Question: Compose a caption that would accompany this figure in a paper.
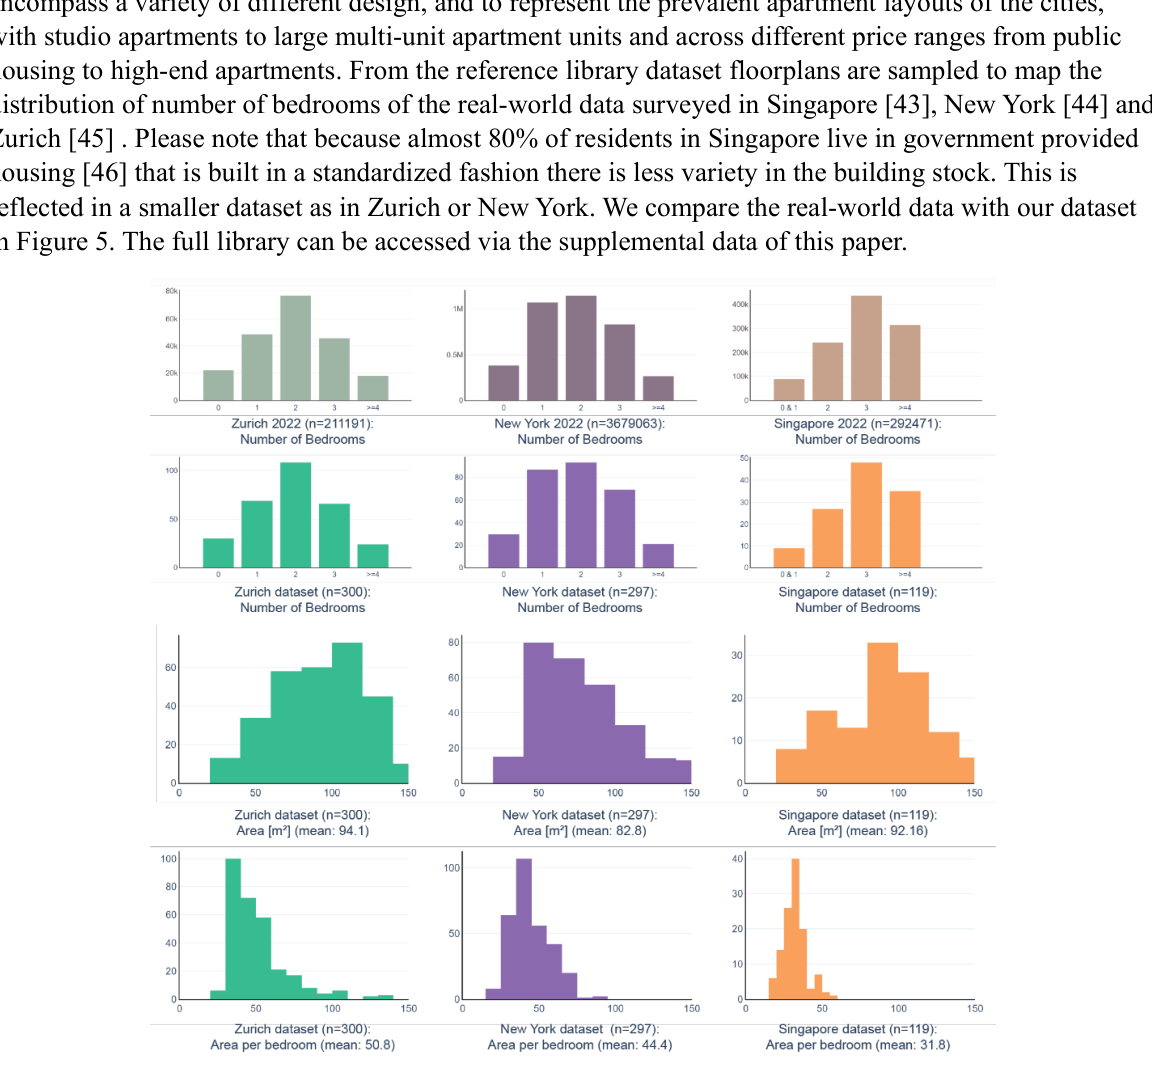
Answer: Distribution of the number of rooms of the cities of Zurich, New York and Singapore, compared with our reference  dataset of analyzed floorplans.